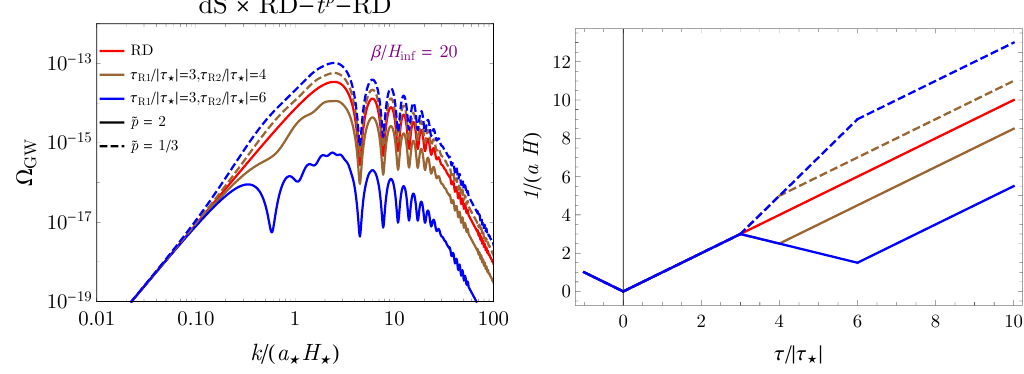
Figure 9 . GW spectrum from first-order phase transition during the quasi-de Sitter inflation, with the post inflationary RD − t ˜ p − RD scenario. Possible intermediate stages with ˜ p = 2 (solid) ˜ p = 1 / 3 (dashed) which corresponding to the domain wall and kination cases in table 1 are included. The red curve corresponds to the dS × RD scenario. The brown and blue curves are for different ratios of τ R / | τ ? | and τ R / | τ ? | , respectively. The solid line is for ˜ p = 2 while the dashed line is for ˜ p = 1 / 3 . 1 2 The right panel shows the comoving horizon